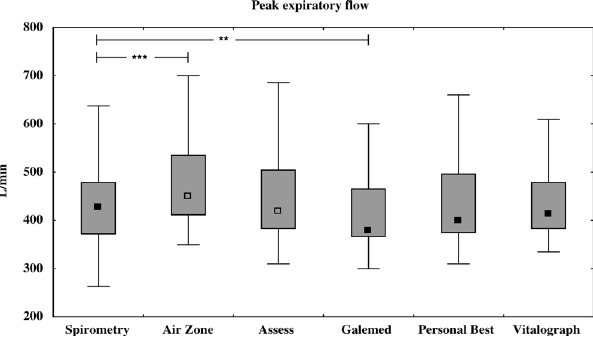
Figure 1 - Peak expiratory flow median values and interquartile ranges referring to the spirometry and the five meters. Friedman’s Test, Dunn’s post-hoc, **p<0.01;